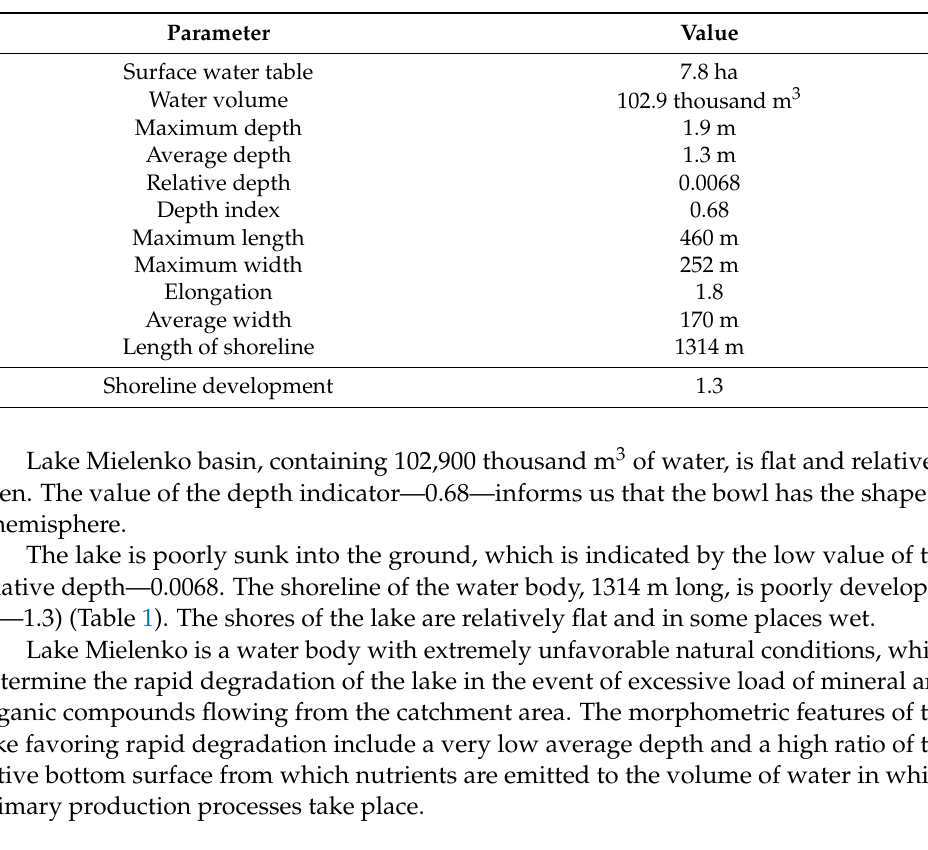
Table 1. Morphometric data of Lake